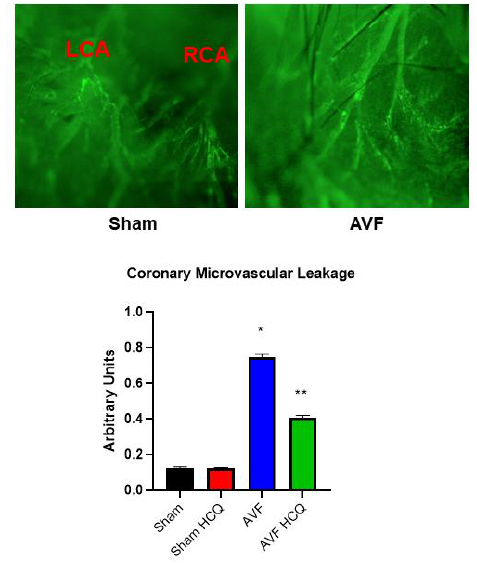
Figure 6. In vivo coronary microvascular permeability using FITIC-albumin: the upper panels are representative florescence angiography from sham and AVF hearts. The bars graph (arbitrary unit) displays AVF and sham mice with and without the HCQ treatment. *, <0.05 compared with sham, **, <0.05 compared with AVF; n = 5–8 in each group.